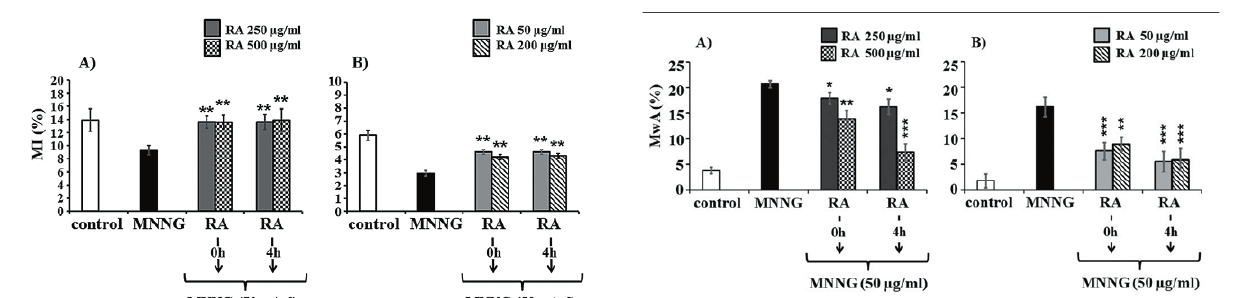
Figure 8. Anti-cytotoxic potential of rose essential oil assessed by mitotic index (MI) applying experimental schemes with: - Rosa alba L. essential oil conditioning treatment prior to MNNG challenge (50 μg/ml) with 4 hours inter-treatment time and, - without any inter-treatment time in Hordeum vulgare (A) and in human lym- phocyte cultures (B). Mitotic activity is calculated as a percent of the control. Data are expressed as mean ± SD of three independent experiments. **p<0.01 compared with MNNG.